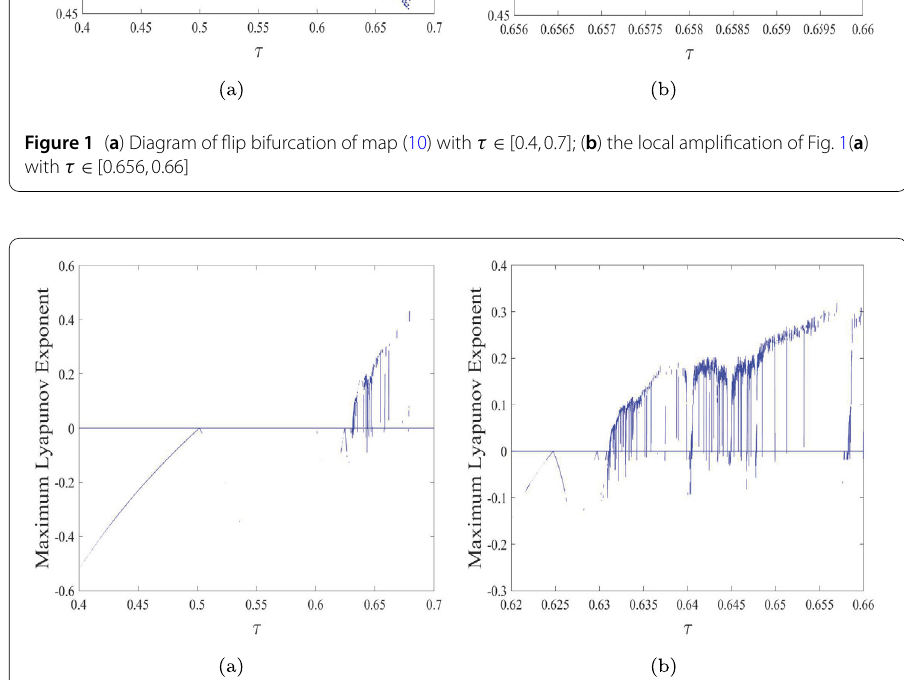
Figure 2 ( a ) Maximum Lyapunov exponents corresponding to Fig. 1( a ); ( b ) the local amplification of Fig. 2( a )